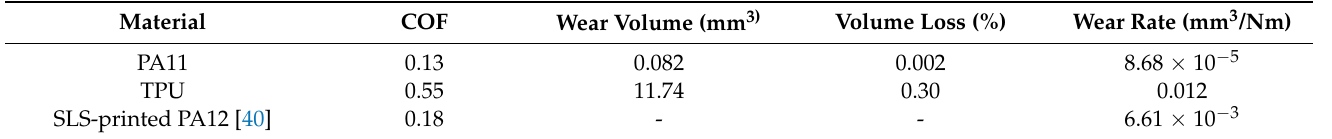
Table 7. Tribological properties of the PA11 and TPU specimens.